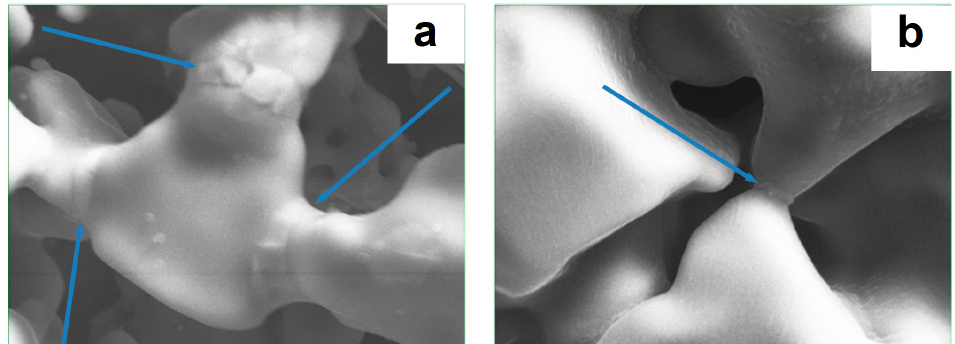
Figure 7. Inter-particle necks formed between V 8 C 7 particles: ( a ) free pressureless SPS at 1550 °C, holding time 40 min, ( b ) conventional sintering at 1550 °C, holding time 180 min. Reprinted from Giuntini et al. [23], Copyright (2013), with permission from Elsevier.